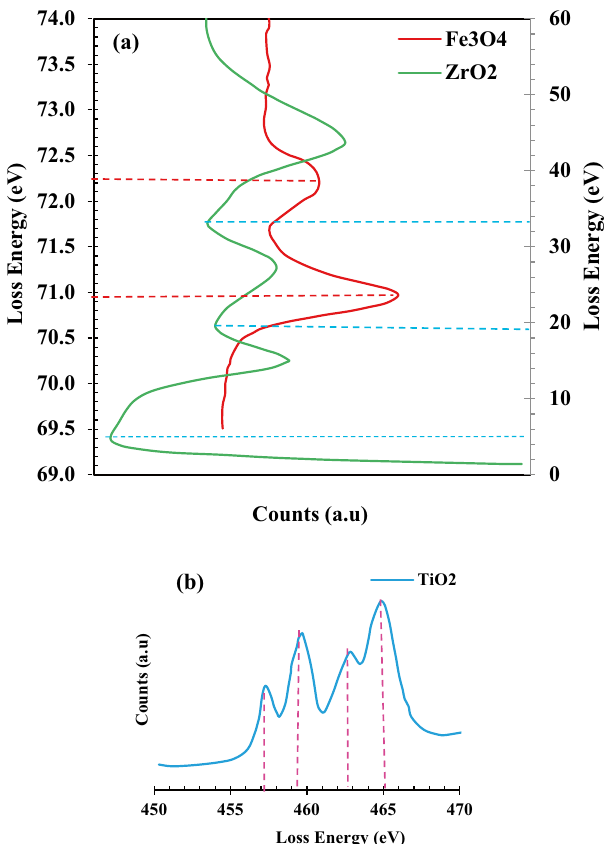
Figure 7. EELS spectrum for Structures of ( a ) Fe 3 O 4 , ( b ) ZrO 2 and TiO 2